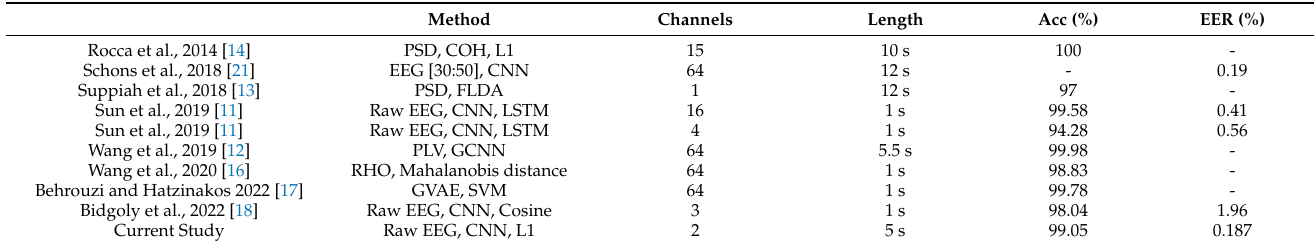
Table 13. Comparison to Related